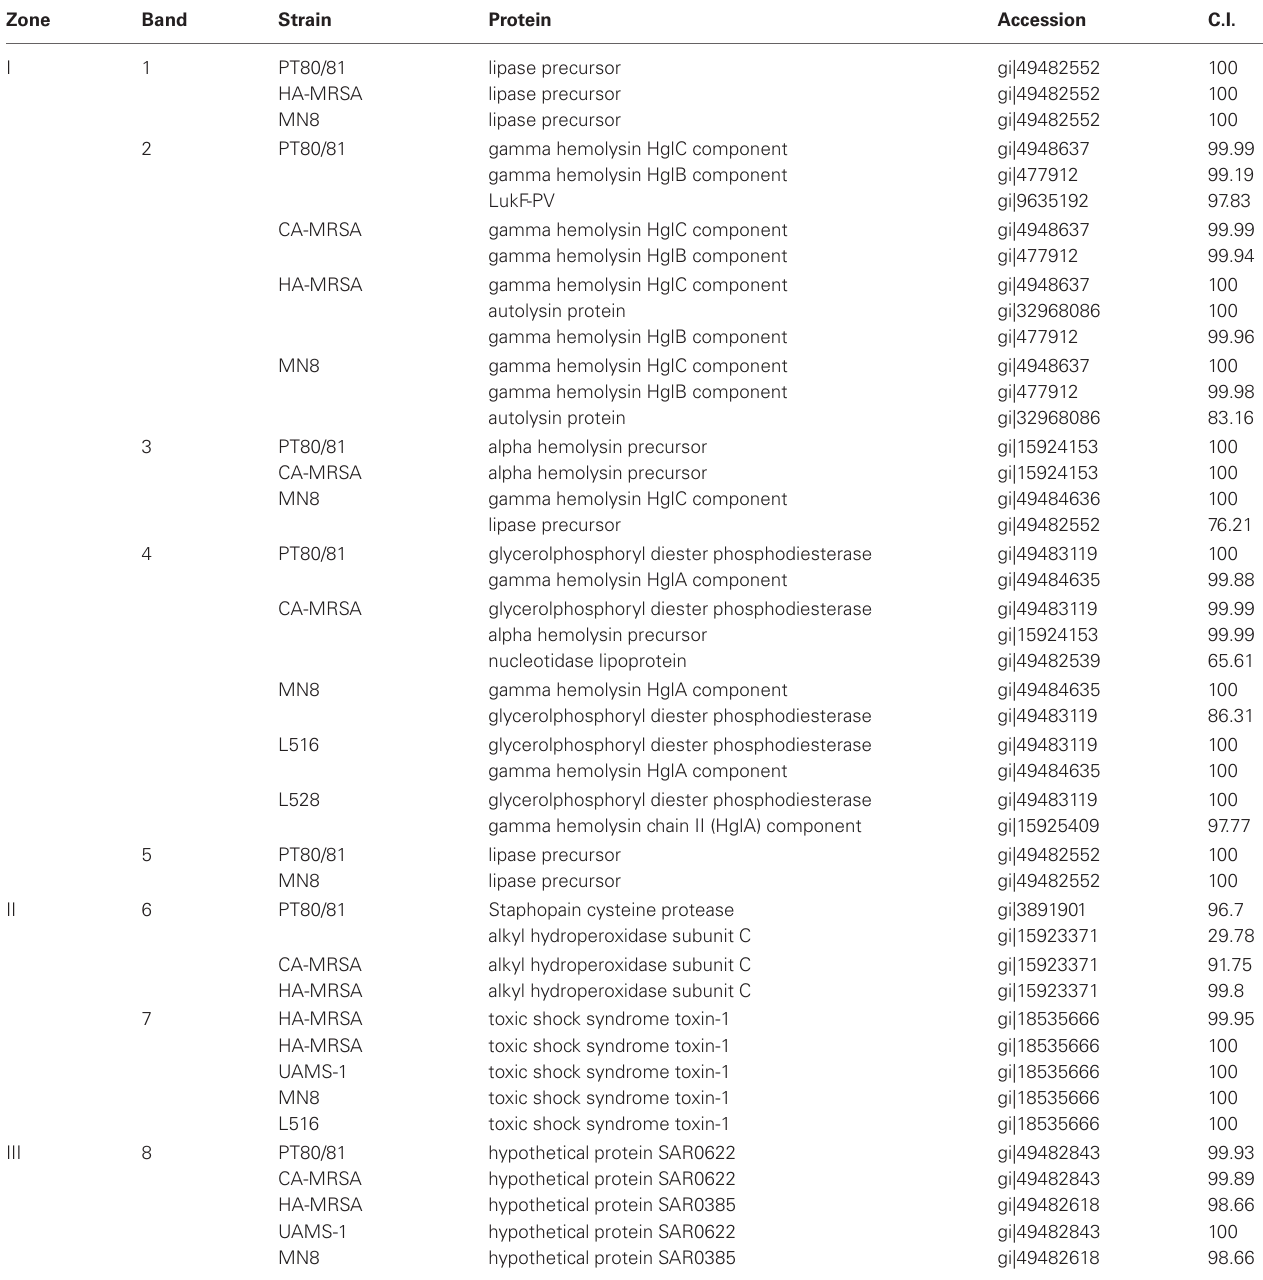
Table 3 | Identity of proteins excised from SDS-PAGE (Figures. 5A and C)